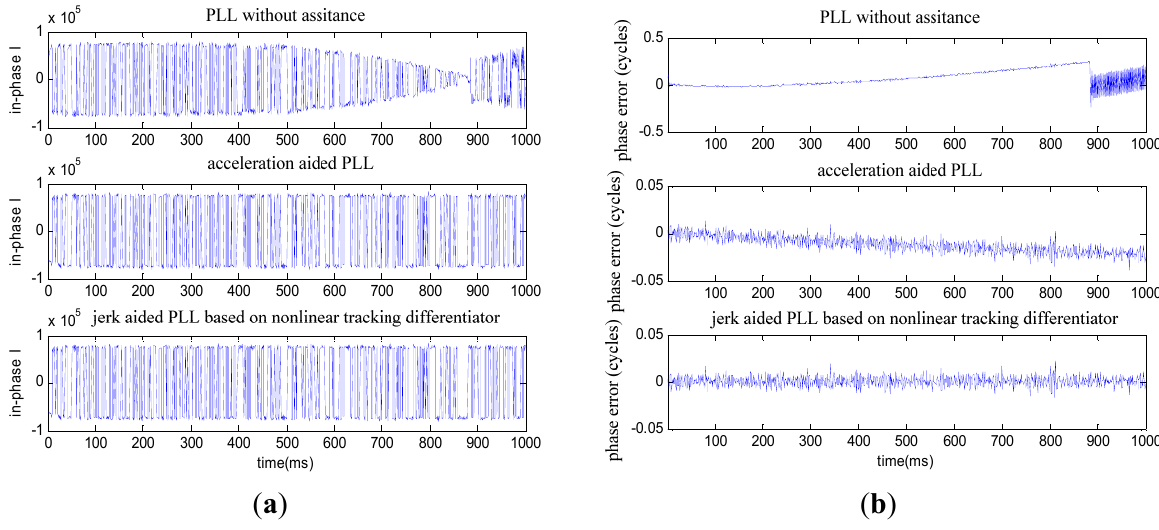
Figure 5. ( a ) Comparison of the in-phase output; ( b ) Comparison of the tracking errors.